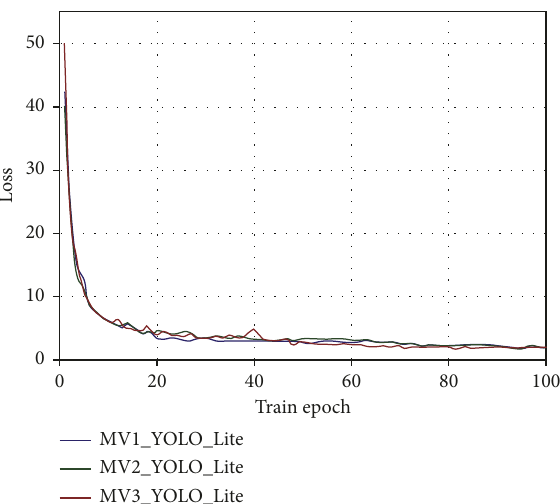
Figure 9: Loss function